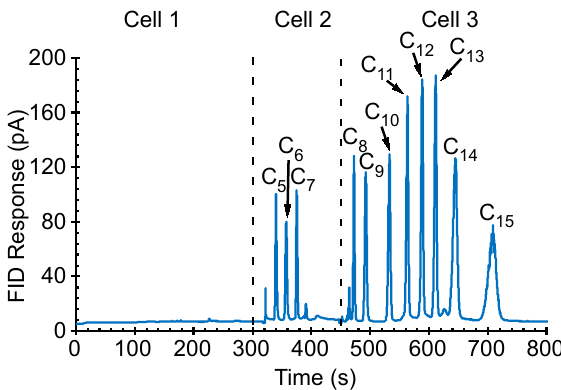
Figure 8. The PCA3mv chromatogram of 30 min sampling of 100 ppb of alkanes C 5 –C 15 . Alkanes C 5 –C 7 were separated in Cell 2, whereas alkanes C 8 –C 15 were separated in Cell 3. The PCA3mv provided R s ≈ 4.7 for the first two eluting analytes (methanol and ethanol) with a RI of 370 and 443, respectively. The PCA3mv also provided R s ≈ 2.3 for the two analytes with lowest vapor pressure (C 14 and C 15 ) with a RI of 1400 and 1500, respectively. All the separations were performed with ∆ T avg of 41.7 ◦ C over 12 min